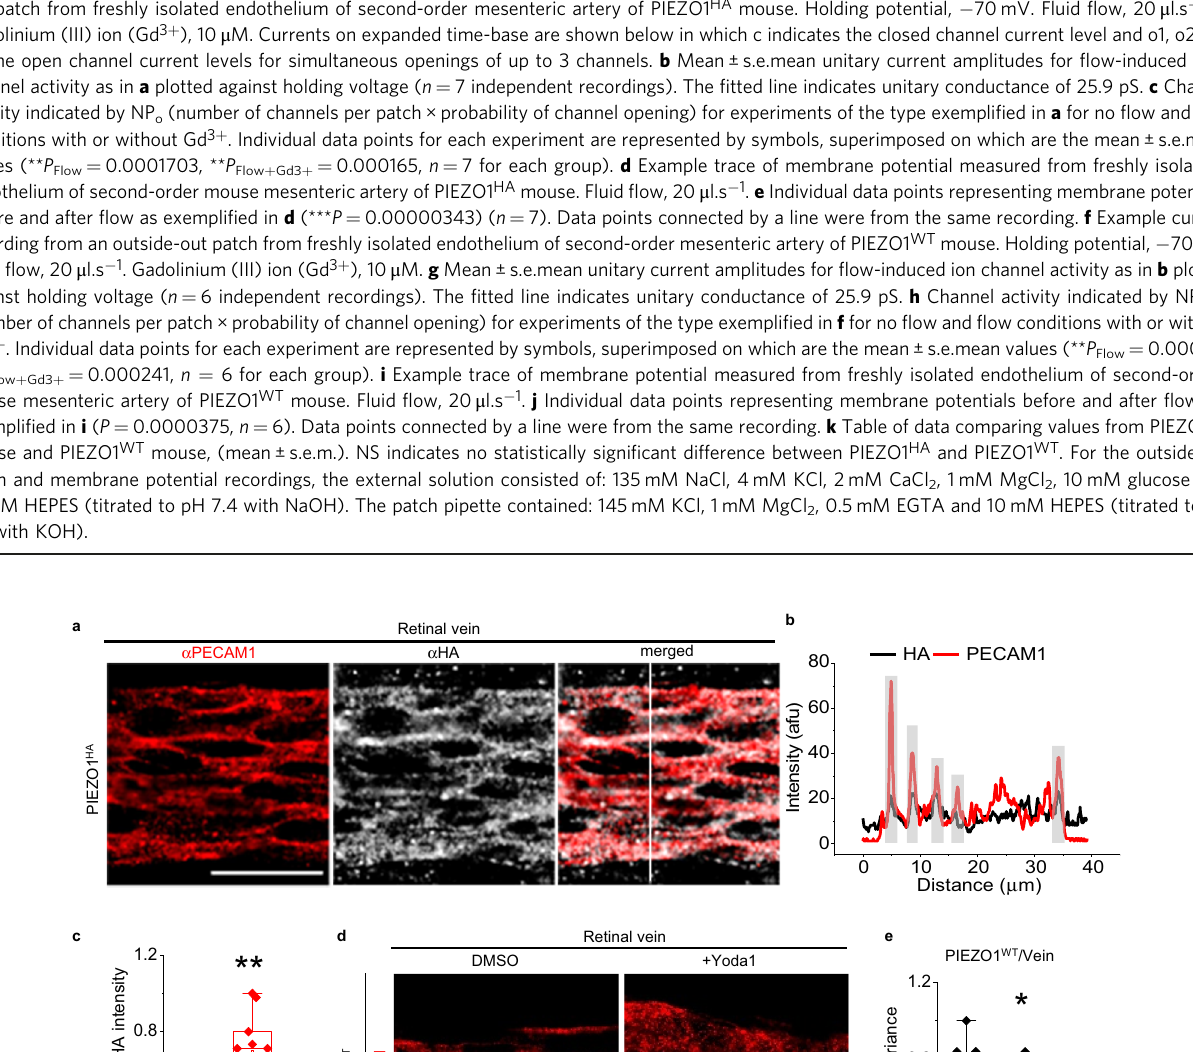
Fig. 2 Endogenous PIEZO1 is close to and can disrupt PECAM1 at cell-cell junctions. a Images for retinal vein of PIEZO1 HA mouse after immuno-staining with α PECAM1 (red) and α HA (grey). The image on the right side is a merged α PECAM1 and α HA image. Scale bar, 20 µ m. b Line-intensity plot for the vertical scan line superimposed in the merged image of a . Grey highlighting indicates cell-cell junctions. c Box-plot quanti fi cation of image intensity for PIEZO1 HA retinal veins stained with α HA antibody, shown in arbitrary fl uorescence units (afu) normalised to the background measurements in the same afu. ** P = 0.00127 for the comparison of the regions with ( + ) or without ( − ) PECAM1. Superimposed data points are average intensity of individual images ( N = 11). Data are for n = 3 independent experiments. d Data obtained after WT mice were infused for 30 min with standard bath solution (SBS) containing DMSO (the solvent for Yoda1) or 3 µ M Yoda1. Representative images of d retinal vein immuno-stained with α PECAM1 antibody. Scale bar, 20 µ m. Box-plots e show coef fi cients of variance calculated from scan lines that were vertical to a blood vessel oriented from left to right (* P = 0.02728 for Yoda1 cf DMSO in vein). Lower variance indicates less organised structure. n = 3 independent experiments and 3 replicates were used in each case. Superimposed data points are the coef fi cient of variance for individual images (DMSO, N = 9 and + Yoda1, N =